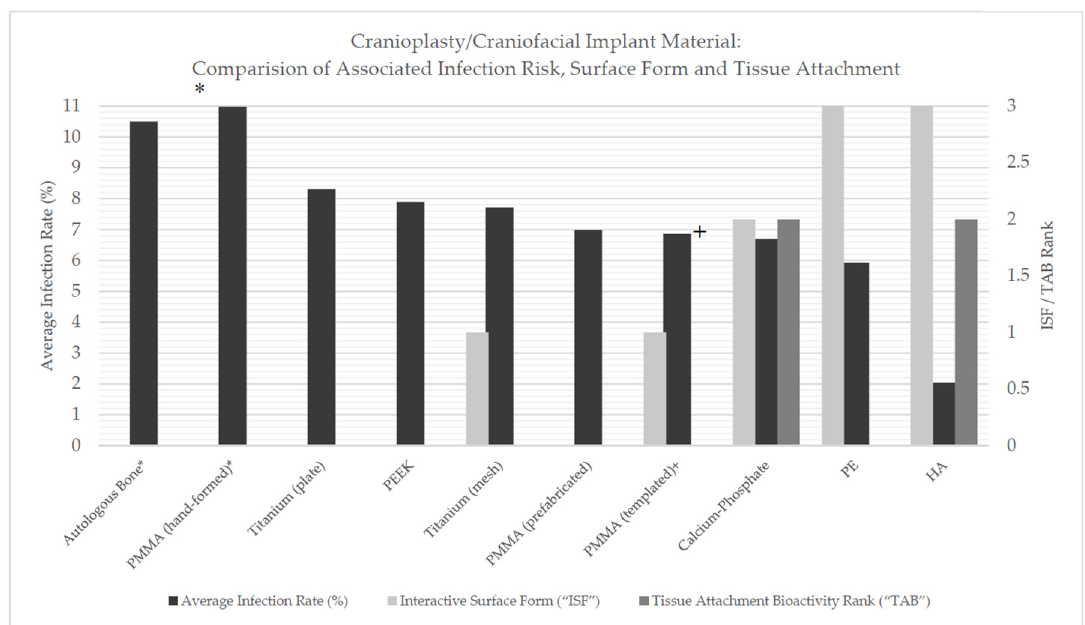
Figure 1. Cranioplasty/craniofacial implant material: comparison of associated infection risk, surface form and tissue attachment. * Indicates implant formation via direct handling of the implant material in surgery; + Indicates implant formation via custom molding template in surgery. Table 11 highlights the results of the one ‐ way ANOVA test conducted. Table 11. One ‐ way analysis of variance (ANOVA) test for statistical significance between all examined implant materials and associated average infection rate.